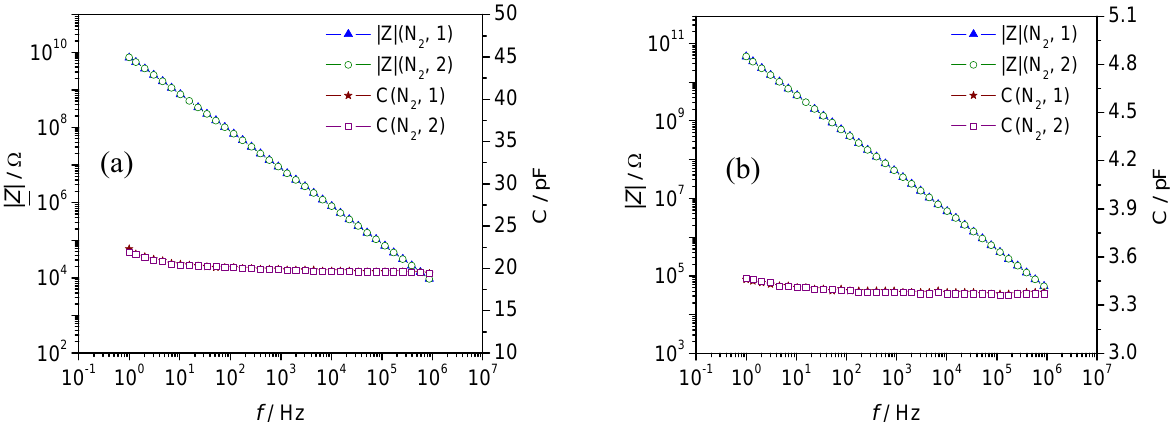
Figure 4. Reproducibility of the impedimetric sensor signal (| Z | and C ) in N atmosphere in two consecutive measurements. Frequency range 1 Hz - 1 MHz. (a) Screen- printed planar IDE sensor configuration with Fe-BTC. (b) Pellet-type sensor of Fe-BTC. T = 120 °C.